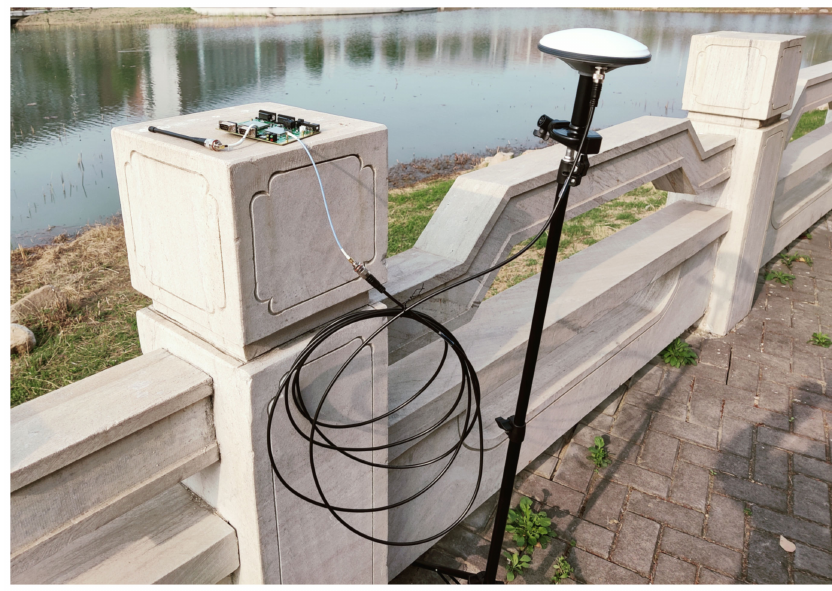
Figure 5. Differential reference